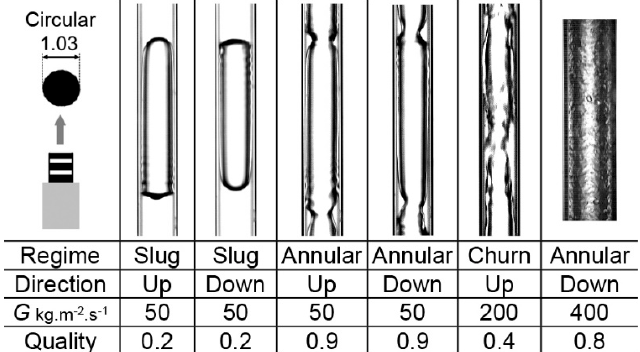
Figure 10. Circular channel visualization with pylex glass [14].